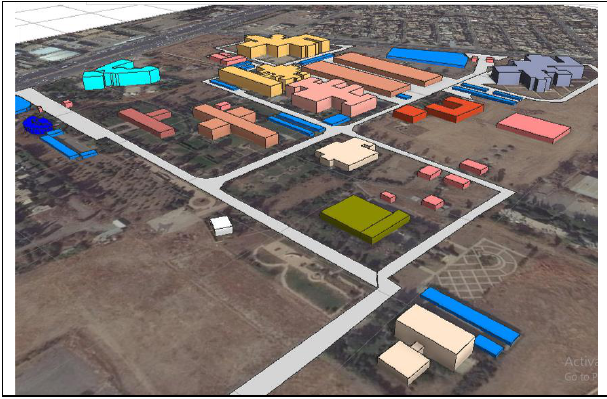
Figure 3. Free world satellite imagery showing the study area with overlying digitised buildings on the ground